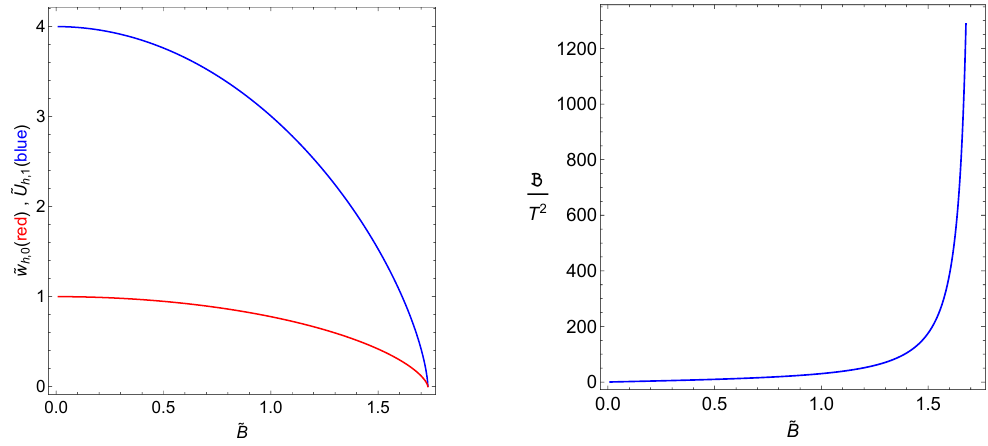
Figure 1 . Left panel: the horizon parameters ˜ U h, 1 and ˜ w h, 0 as functions of ˜ B . Notice that both ˜ U h, 1 and ˜ w h, 0 are defined in units where the horizon radius is at ˜ r = 1 . Right panel: the dimensionless ratio B /T 2 as a function of ˜ B